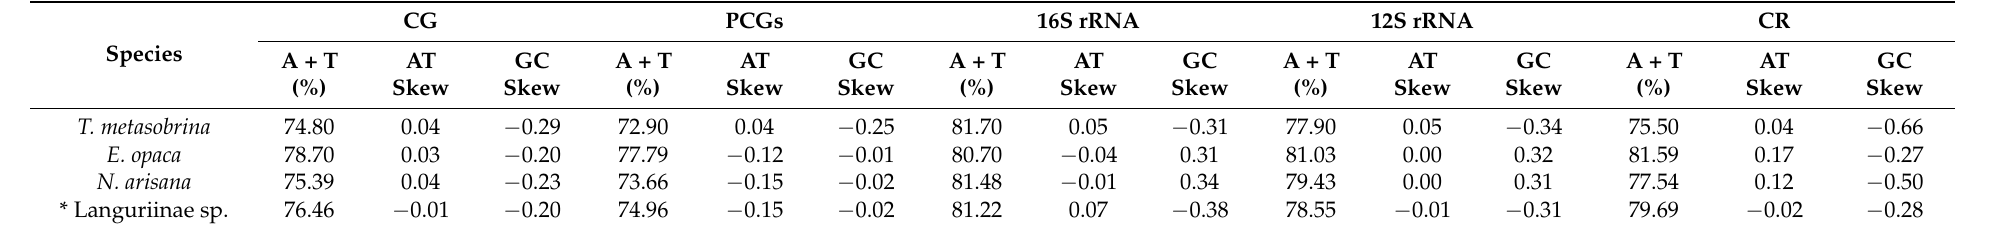
Table 3. Base composition and strand bias of these four